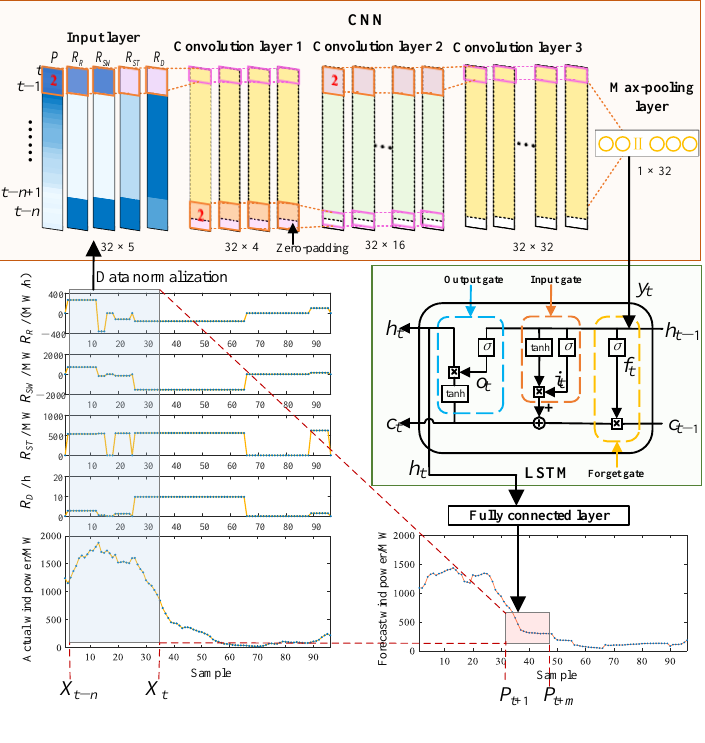
Figure 7. Structure of CNN–LSTM.